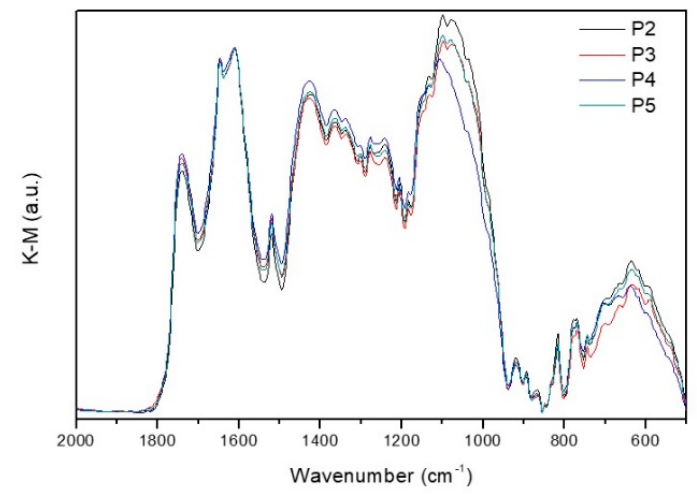
Figure 6. DRIFT spectra of the pectin samples in the 2000–500 cm − 1 region, normalized to the ν as COO − band of carboxylate groups at 1610 cm − 1 .